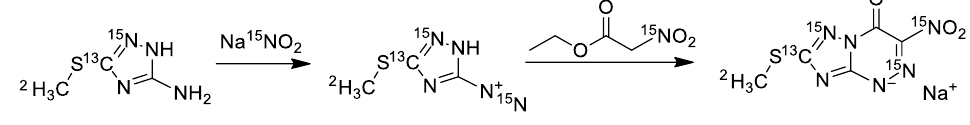
Scheme 4. Synthesis of the selective isotope-labeled TZV.